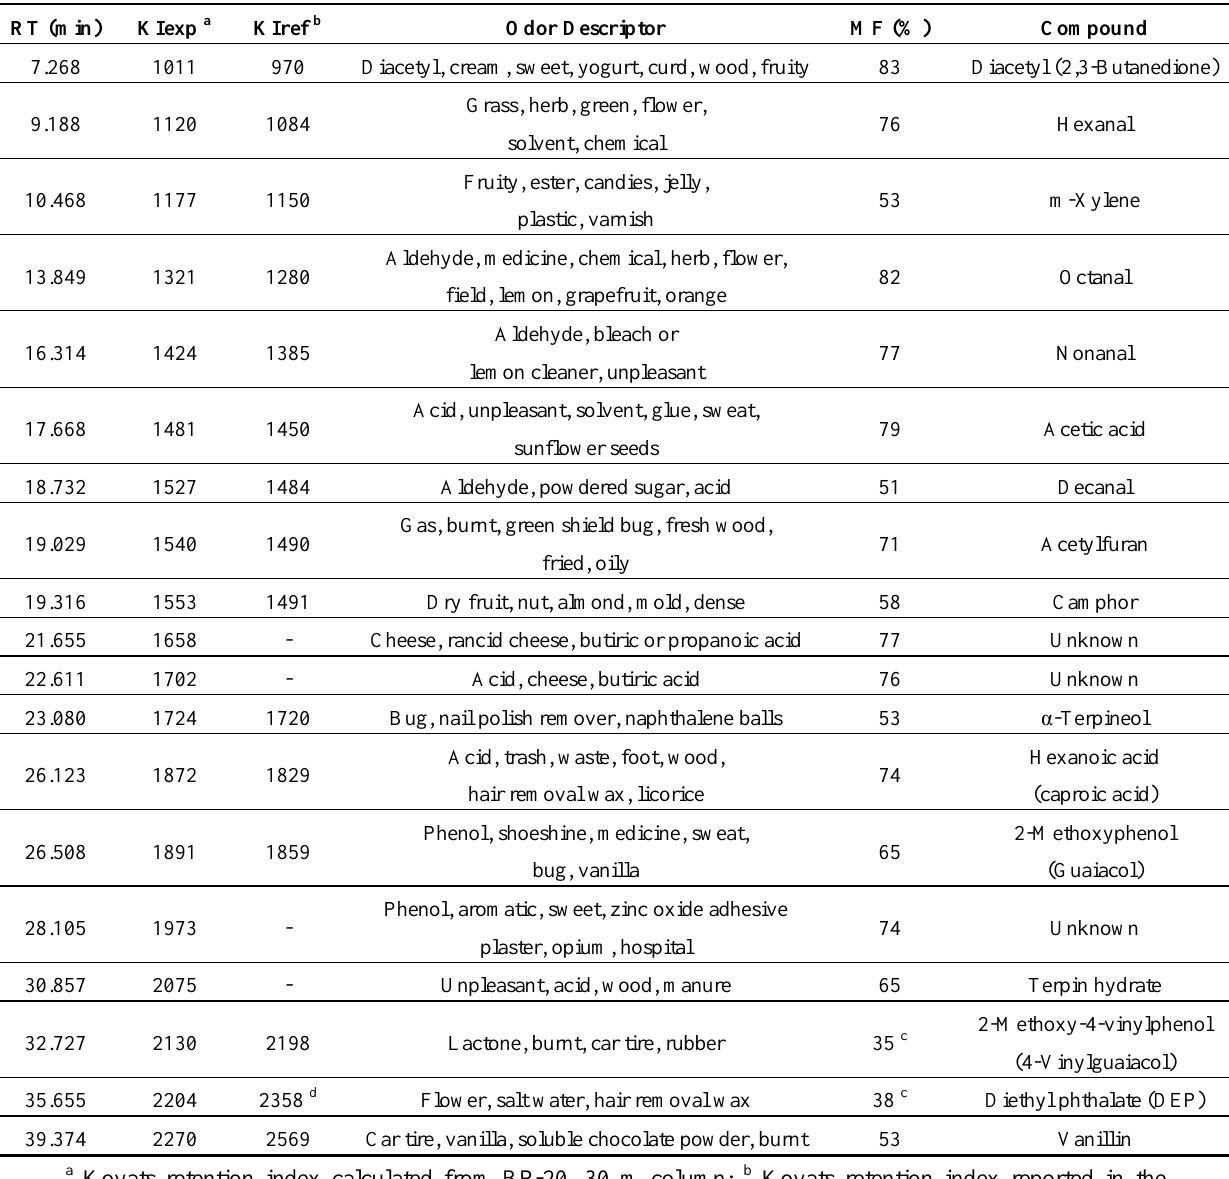
Table 3. Olfactory description, chemical identity and modified frequency percentage MF (%) for each odorant identified in WPC prototype (Adapted from [82] with permission from